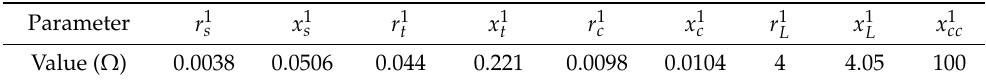
Table 1. The load and system